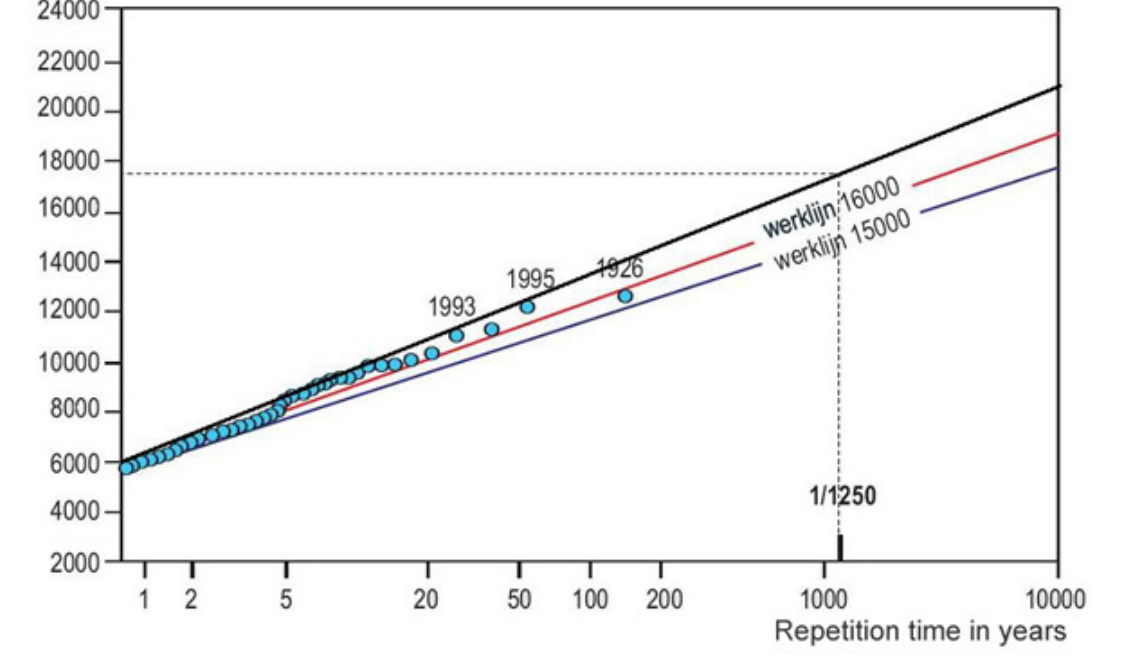
Fig. 3. Peak discharges (m³/s) and their return time of the river Rhine in the Netherlands at gauging station Lobith. Werklijn 15,000 and 16,000 stand for the design discharges 15,000 and 16,000 m³/s respectively that occur 1/1250 yr under different extrapolations. The upper and second highest lines represent design discharges under two different climate change scenarios (Botzen and van den Bergh